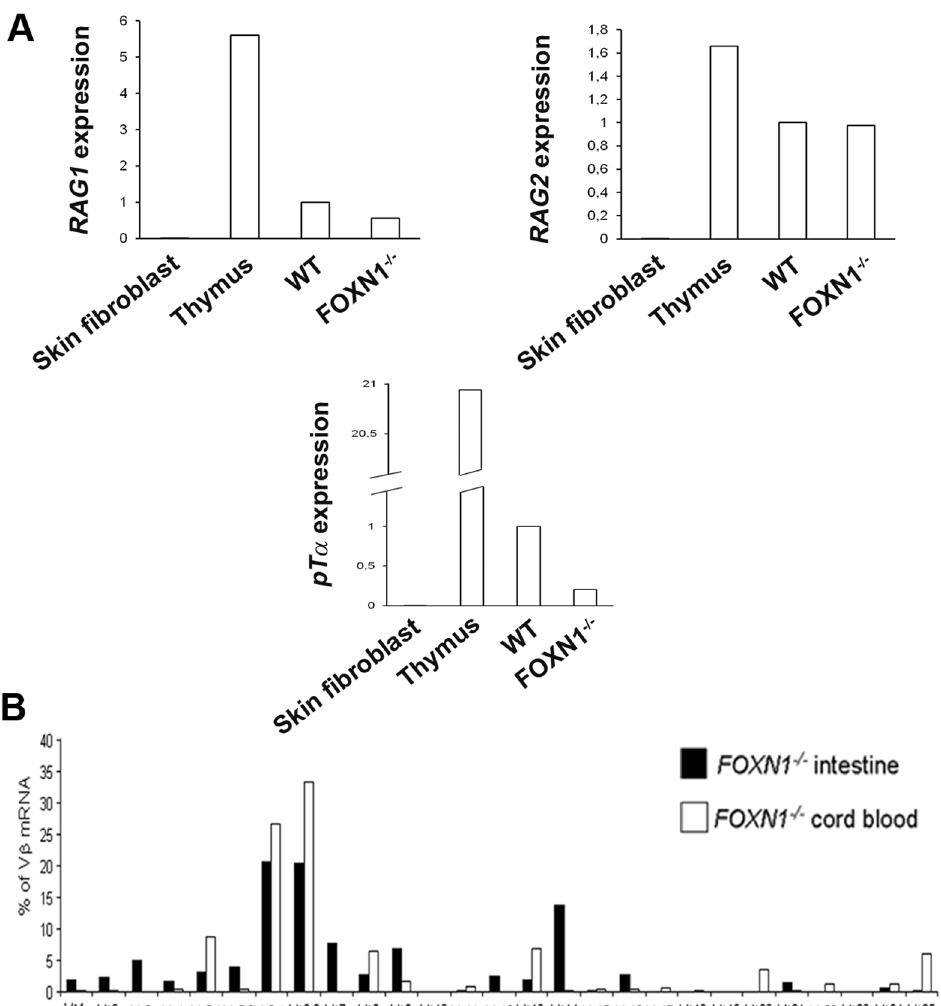
Figure 4. Local production of T cells in the FOXN1 2 / 2 human intestine. (A) Quantitative real-time PCR showing the expression of mRNAs encoding RAG1, RAG2 and pT a (relative to b -actin) in skin fibroblasts (negative control), thymus (positive control) and intestinal tissue of control and FOXN1 2 / 2 fetuses (16 weeks of gestation). (B) Comparison of TCR V b -region usage between intestinal lymphocytes (black bars) and CBMCs (white bars) from the FOXN1 2 / 2 fetus. Experiments were repeated three times in (A) and two times in